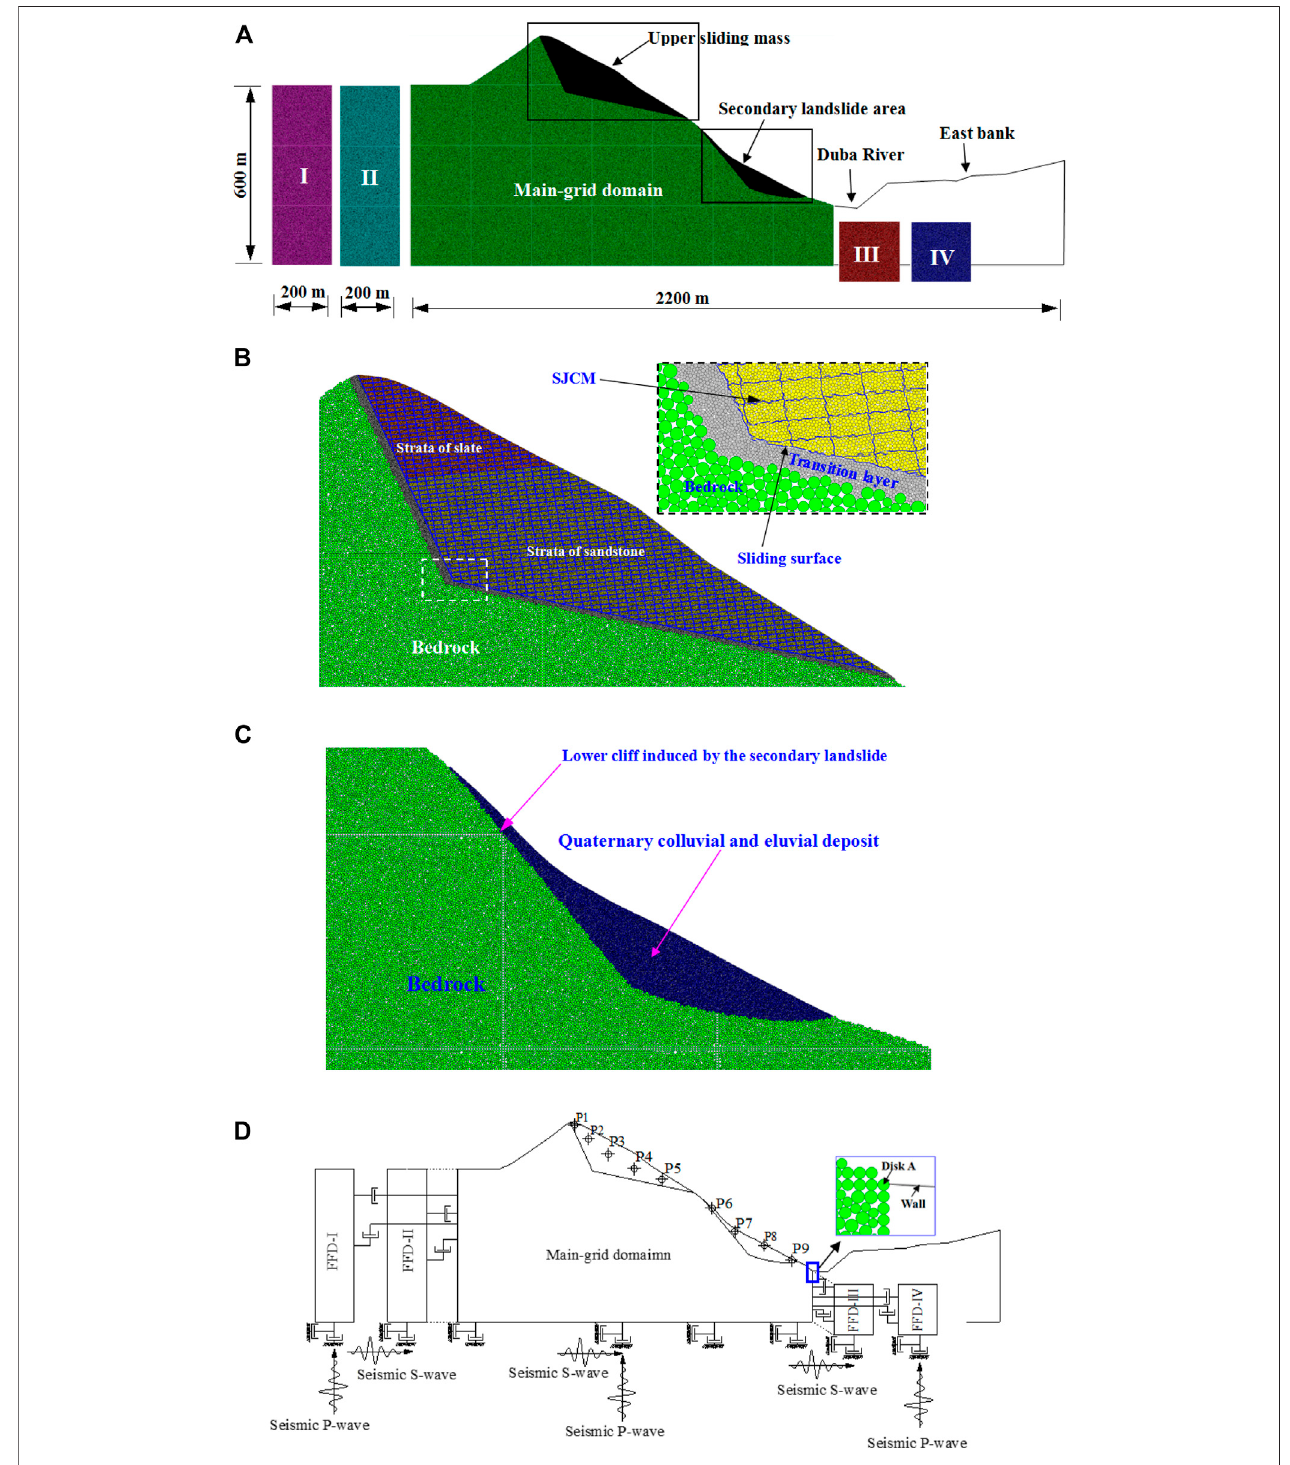
FIGURE7| DEMmodeloftheTaihongcunlandslide. (A) PartIisthefree- fi elddomainI(FFD-I),partIIisthefree- fi elddomainII(FFD-II),partIIIisthefree- fi elddomain III(FFD-III),andpartIVisthefree- fi elddomainIV(FFD-IV). (B) Upperslidingmassandbedrock. (C) Secondarylandslidearea. (D) Dynamicboundarysettingandlocations of monitoring disks for the landslide.